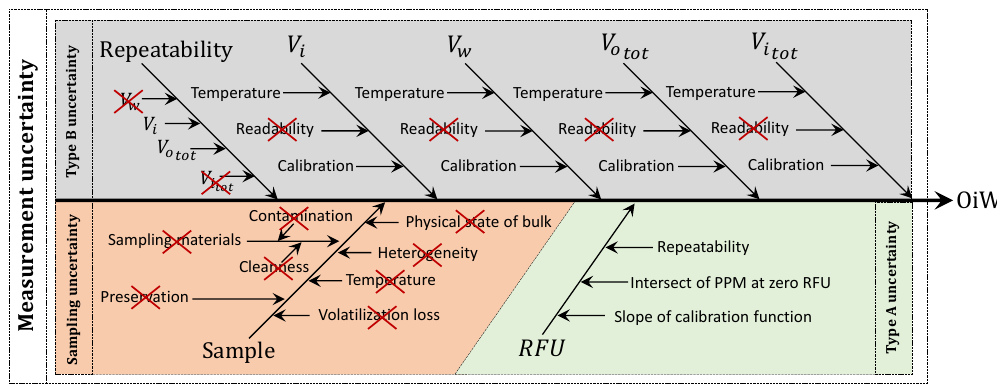
Figure 14. Cause-and-effect diagram of compounded uncertainties contribution to the measurement of OiW concentration by following the uncertainty related to each equipment used for mixing the eight different solutions. The cause-and-effect diagram is divided into three sub-groups: type B uncertainties (gray), type A uncertainties (green), and sampling uncertainties (orange).